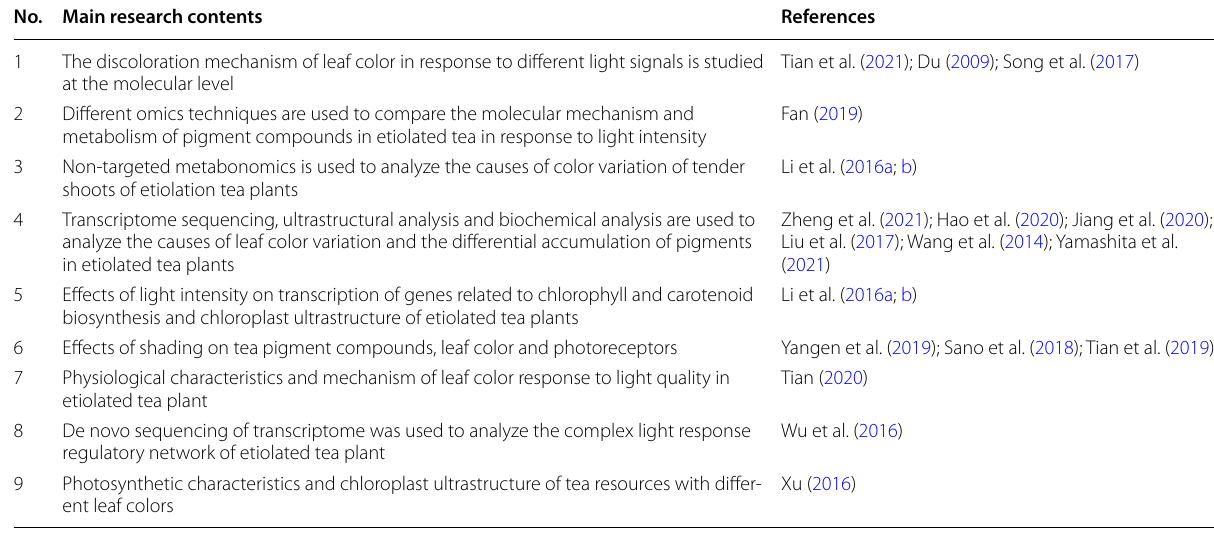
Table 3 Research progress of key pigment compounds of photosensitive etiolation tea